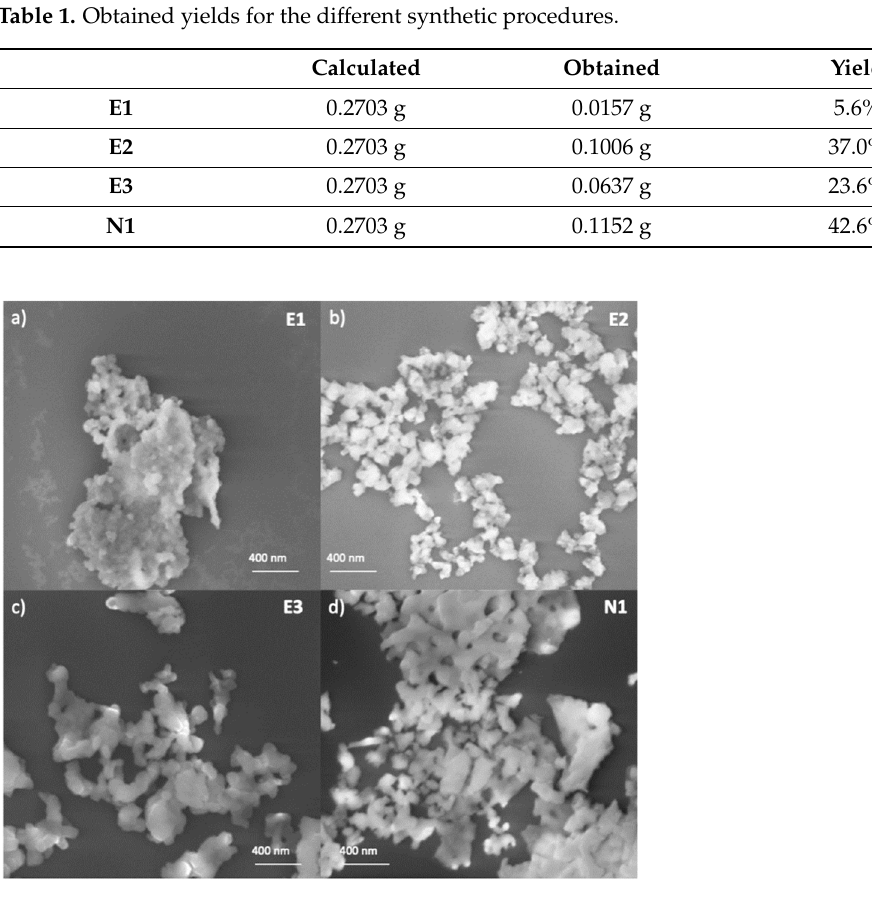
Figure 1. SEM micrographs of the core Er- and Nd-doped Y 2 O 3 NPs, after synthesis and annealing, deposited onto an Si wafer for ( a ) sample E1, ( b ) sample E2, ( c ) sample E3 and ( d ) sample N1.